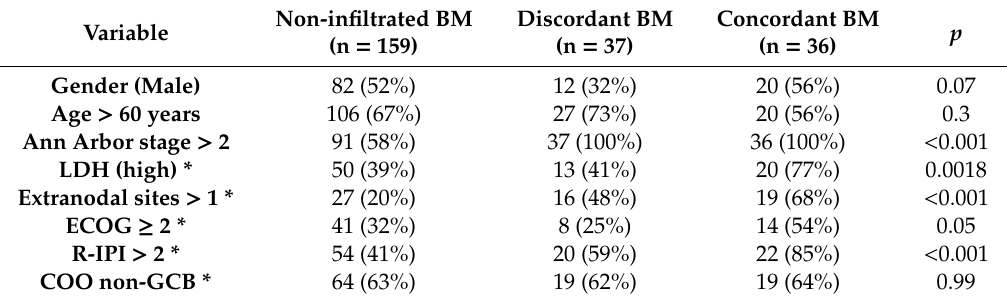
Table 1. Patient characteristics according to the bone marrow